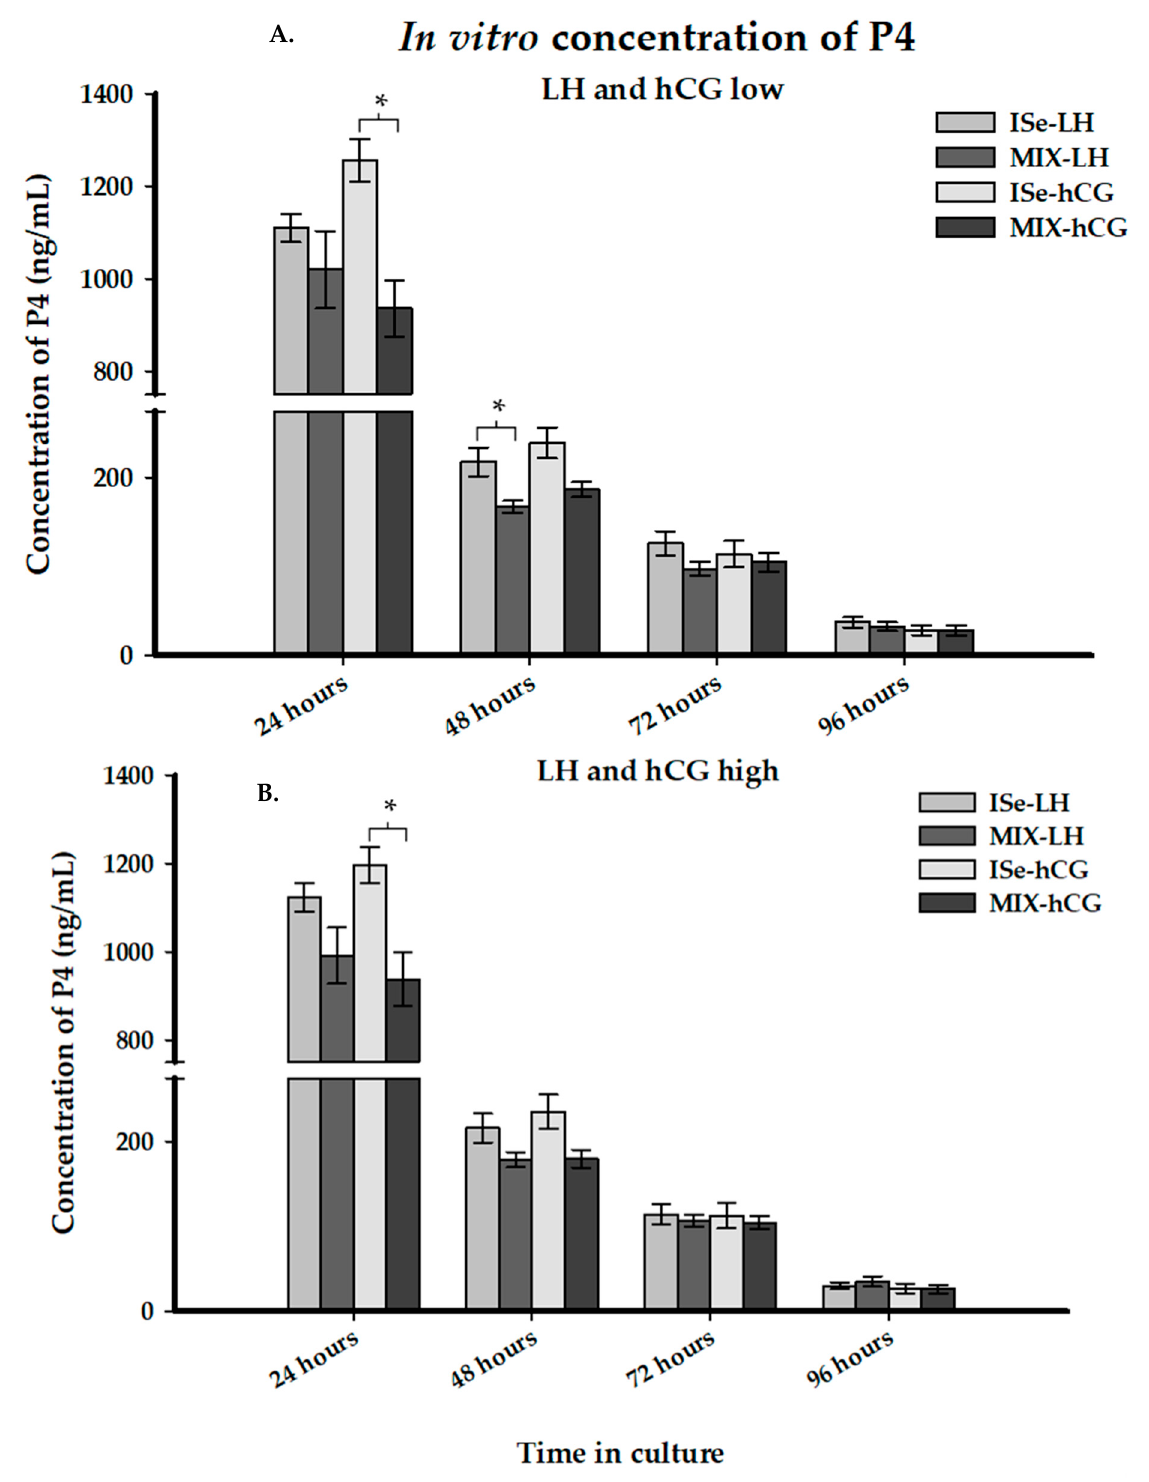
Figure 5. Effect of form of Se on concentrations of P4 in culture media (ng/mL; LS mean ± standard error of the mean) collected after in vitro culture of dissociated luteal cells with a low ( A ) or high ( B ) dose of LH (1 or 10 IU/mL) or hCG (10 or 50 ng/mL). Corpora lutea were recovered from cows supplemented with either ISe (Sodium selenite; n = 5) or a 1:1 combination (MIX) of ISe and OSe (Sel-Plex; n = 5) on Day 7 post-estrus. Data were analyzed using split plot design for repeated measure. Significant differences were determined at p < 0.05 and are designated by an